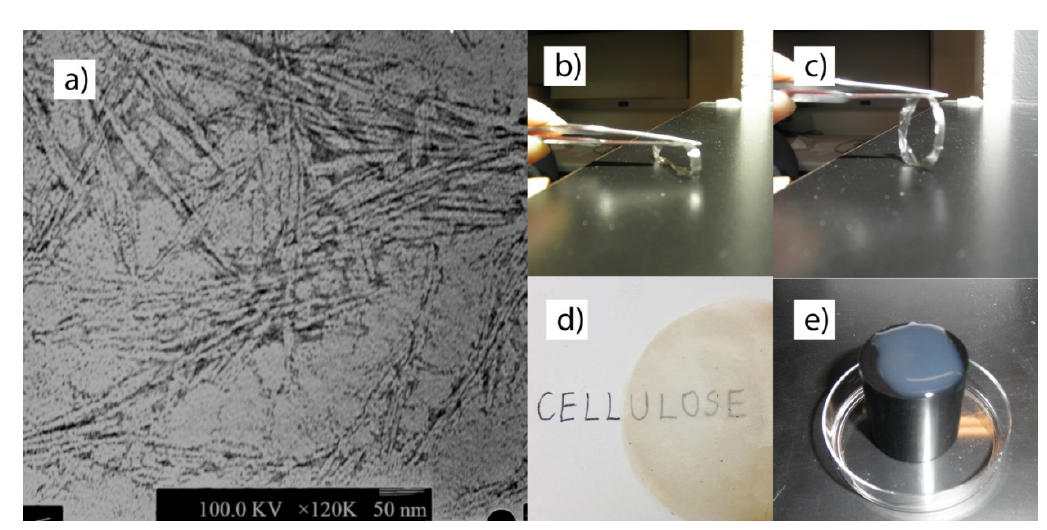
Figure 4. ( a ) TEM micrograph of CNC-SW-AH; ( b , c ) membrane made by 100% CNC-SW-AH; ( d ) the transparency of CNC-SW-AH membrane and ( e ) the liquid crystal solution of